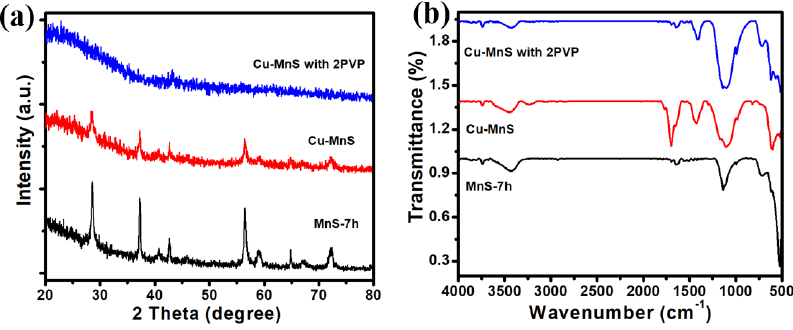
Figure 2. XRD ( a ) and FTIR ( b ) patterns of the MnS, Cu-MnS, and Cu-MnS with 2PVP nanocomposite.